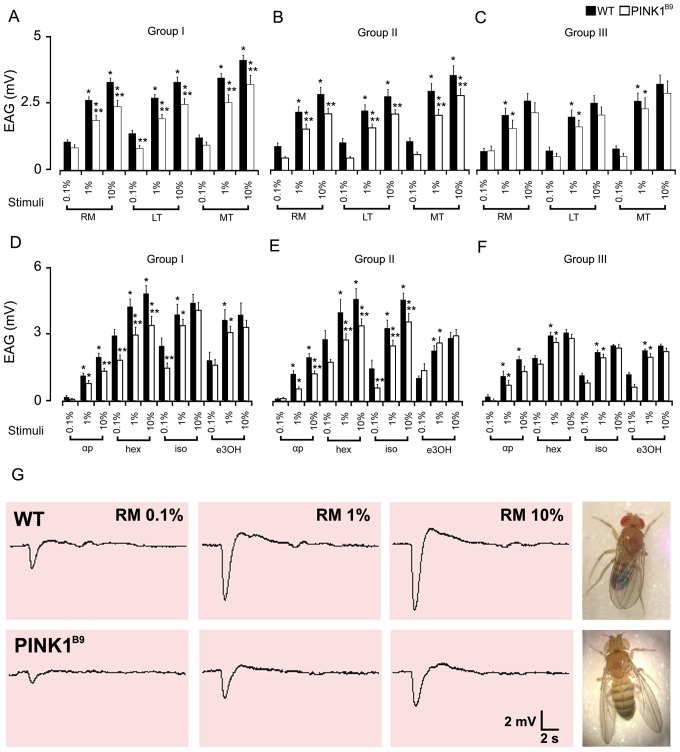
Electroantennogram responses in wild type and PINK1B9 mutants.Dose-response relationships for olfactory stimulations in WT and PINK1B9 adult flies and their differences in signal amplitude. Histograms in A and D show the EAG results in flies from Group I (age range from 3 to 6 days), from Group II (age range from 15 to 20 days) in B and E and from Group III (age range from 27 to 30) in C and F. Values shown are mean ± S.E.M. of the EAG amplitude. Stimuli are dilutions of essential oils (rosemary, RM; lentisk, LT; myrtle, MT) and synthetic compounds (α-pinene, αp; hexanol, hex; isoamyl acetate, iso; ethyl 3-hydroxybutyrate, e3OH) administered in a 3-step dose from 0.1 to 10% in hexane. EAGs obtained in WT and PINK1B9 displayed strong similarities in the dose-response to stimuli; statistically significant differences were observed between WT and the mutant strains (* significantly different from its previous concentration; ** significantly different from its matching stimulus; P<0.05). In G, representative EAG tracings recorded in WT (upper) and PINK1B9 (lower) in response to olfactory stimulation with rosemary oil (RM) administered in increasing concentrations. The sample tracings show that the amplitude of the depolarization in the baseline is clearly higher in WT than in PINK1B9.